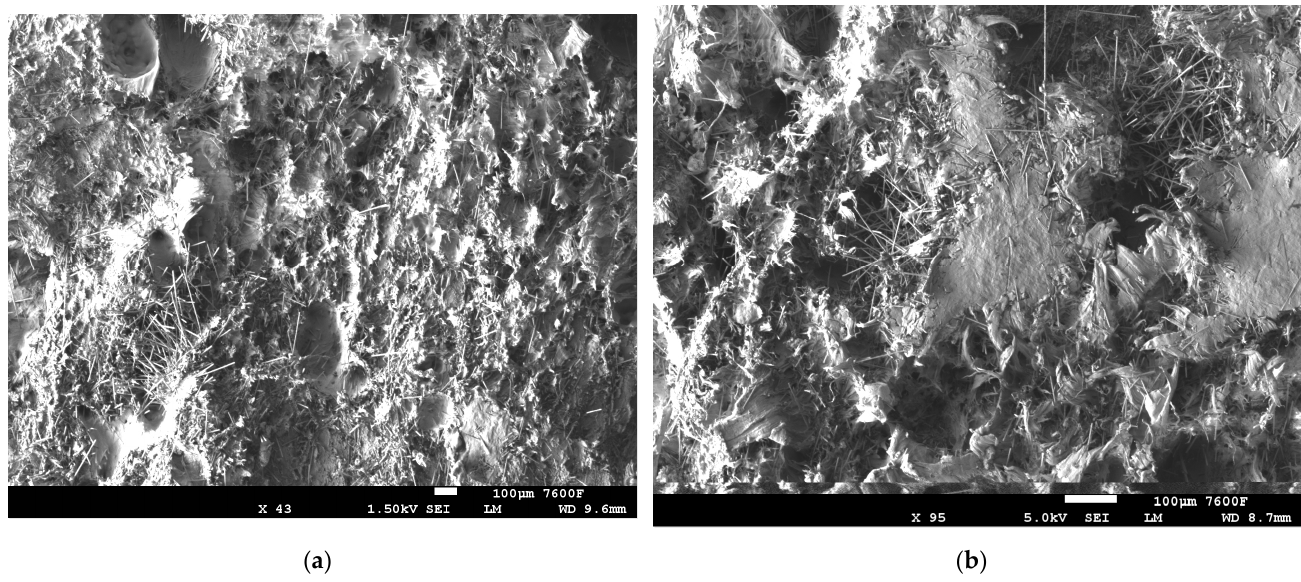
Figure 7. SEM images: ( a ) 10% CF/PE and ( b ) 15% CF/PE combinations. The normal probability plot (Figure 8) chart of tensile strength (TS) for 3, 5, 10 and 15 wt.% CF with plasma PE shows readings well within the specified limit; the distribution, standard deviation and mean values are shown in the figure. The results for tensile strength with CF/PE showed better tensile properties for the 10 wt.% CF/plasma-treated PE combination with a tensile strength value of 21.5 MPa. The same composite combination was tested under different fabrication conditions (Figure 9). Initial test was performed with ‘T 180 20’, i.e., 180 °C temperature for 20 min. Similarly, T 180 40, T 180 60, T 200 20, T 200 40, and T200 60 were fabrication conditions at different temperatures and with different time intervals. Apart from the T180 20 fabrication condition, all other conditions showed reduced properties.